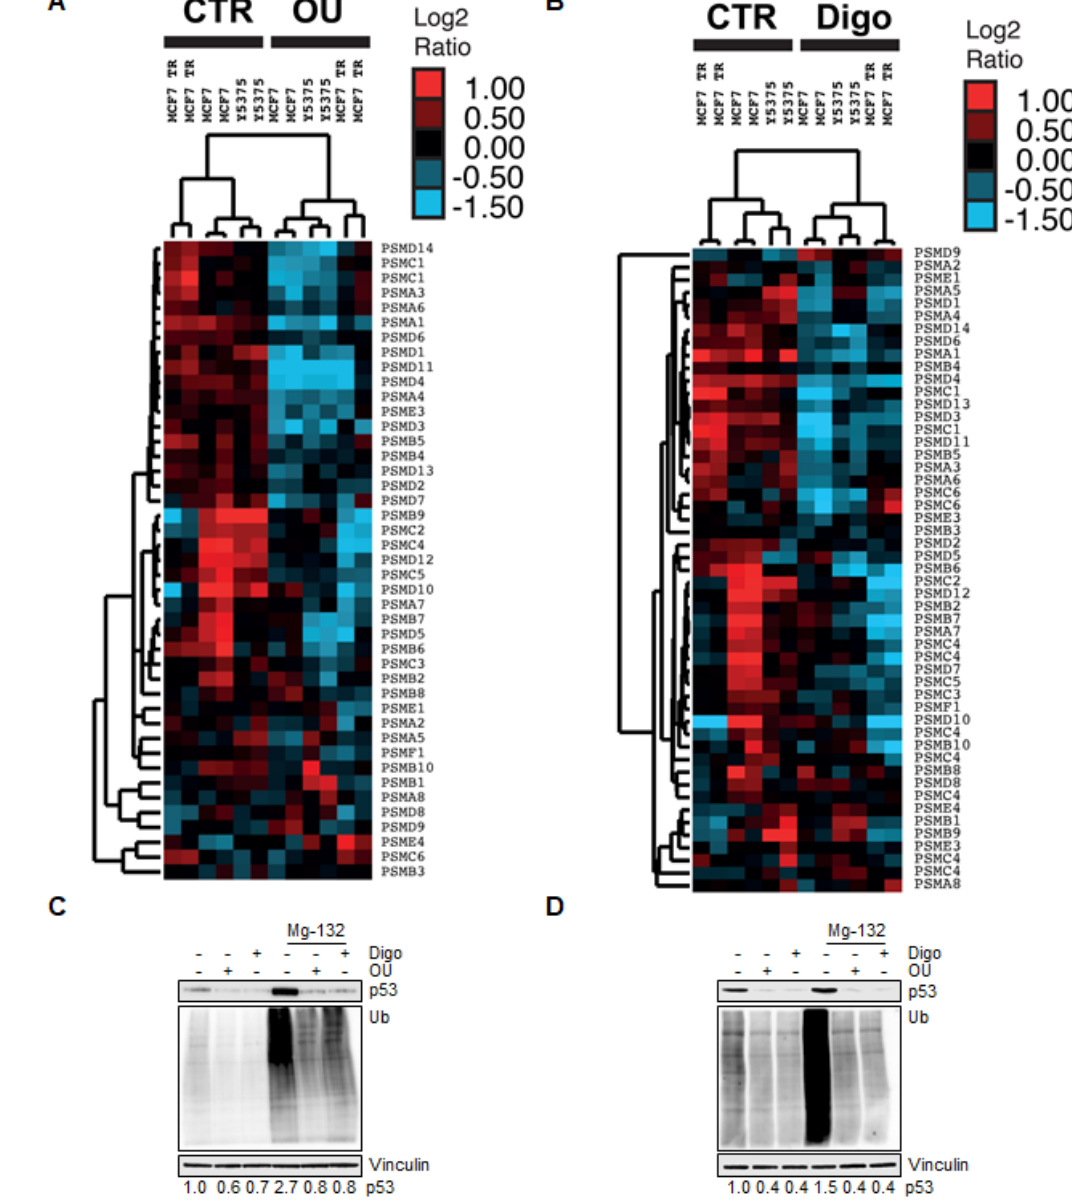
Figure 3. The effects of proteasome genes regulated by ouabain and digoxin on breast cancer cells. Hierarchical clustering analysis of gene expression profiles, relative to 20S proteasome-related gene set, in cells treated for 24 h with OU ( A ) and Digo ( B ). Experiments were performed in duplicates. Western blotting analyses of p53, and ubiquitin (Ub) expression in MCF-7 ( C ) and ZR-75-1 ( D ) cells treated for 24 h with ouabain (OU–100 nM) or digoxin (Digo–1000 nM), both in the presence and in the absence (CTR) of the administration of the proteasome inhibitor Mg-132 (0.5 µ M). All experiments were performed twice in duplicates. The loading control was performed by evaluating vinculin expression in the same filter.